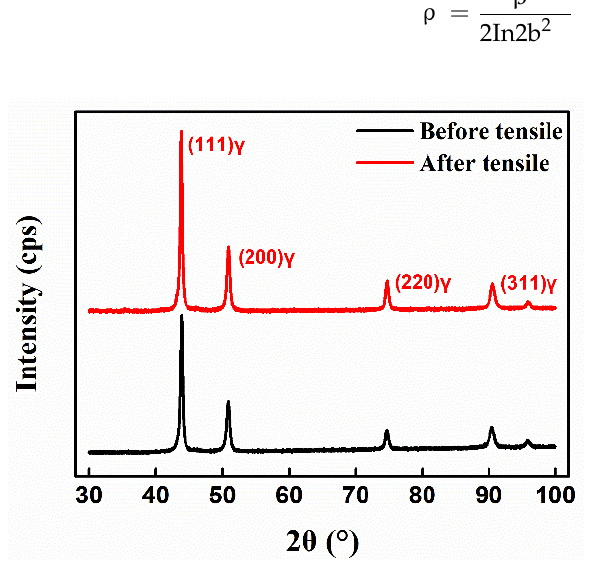
Figure 5. XRD patterns of GH4169 samples before and after tensile treatment.